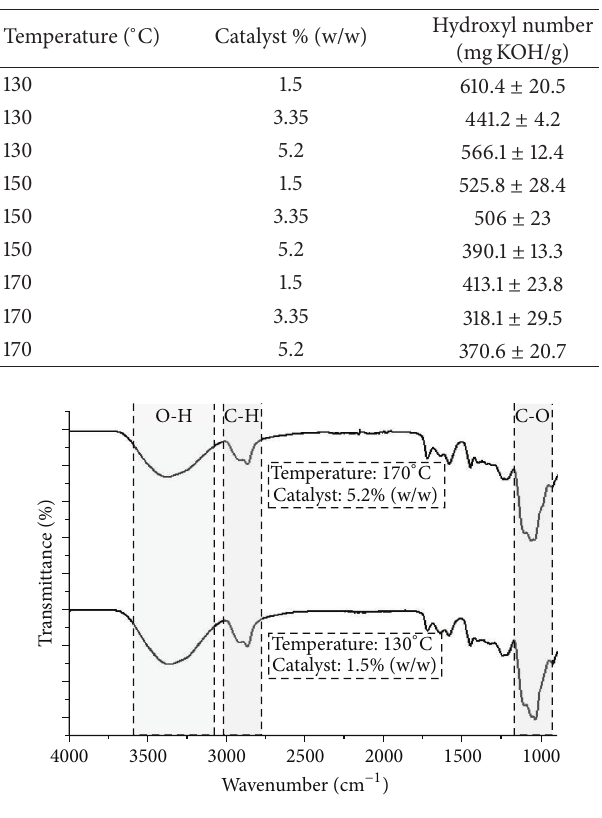
Figure 1: FT-IR spectra of the reaction products of glycerol polymerization performed at 130 ∘ C with a catalyst concentration of 1.5% (w/w) and at 170 ∘ C with catalyst concentration of 5.2% (w/w). The obtained spectra are similar to previously reported polyglycerol spectra [1].